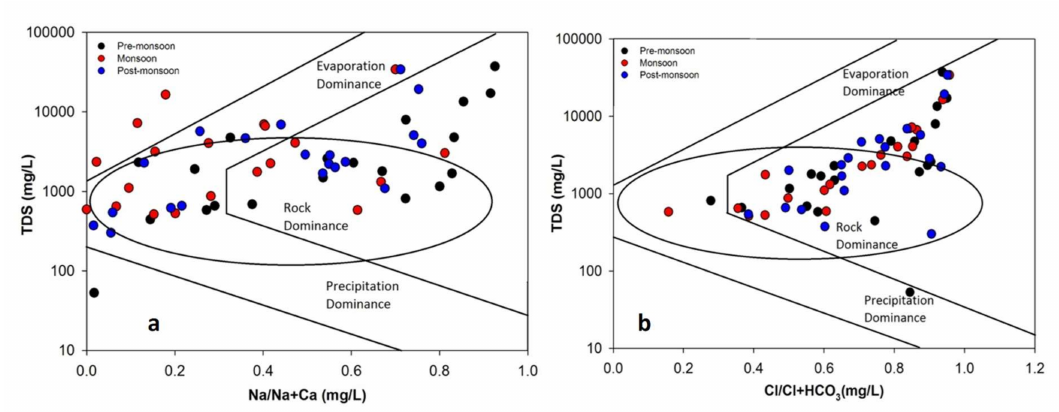
Figure 10. Gibbs plots ( a ) TDS v/s Na + +/Na + + Ca 2+ and ( b ) TDS v/s Cl − /Cl − + HCO 3 −